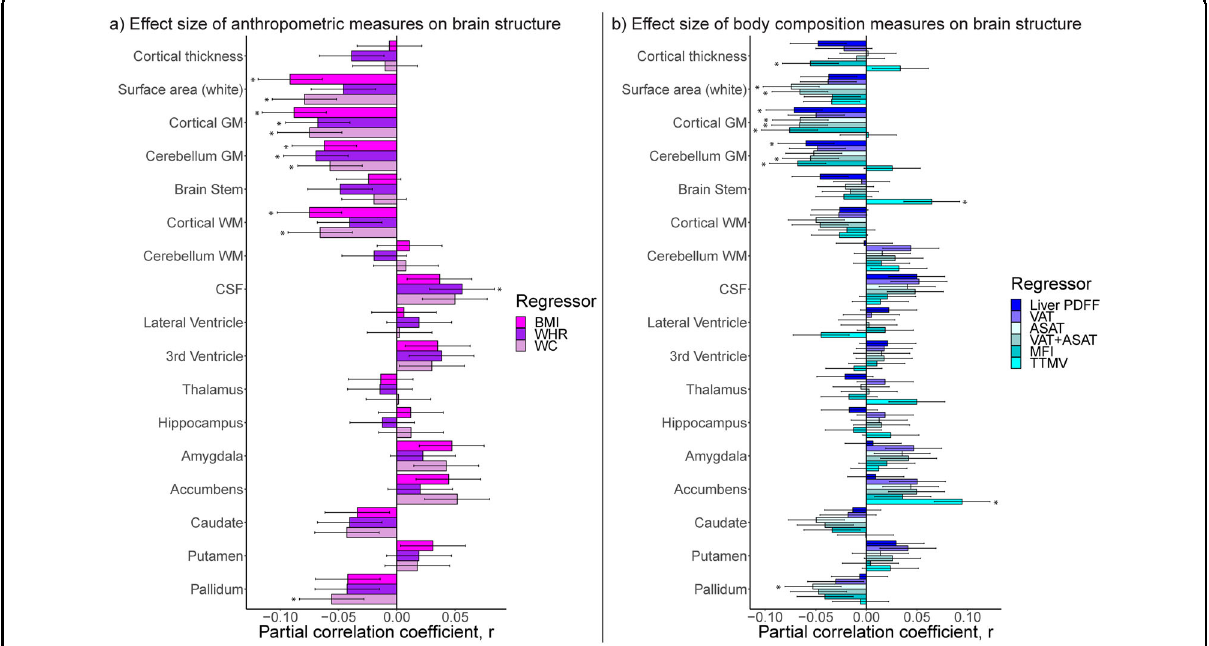
Fig. 4 Linear body – brain association patterns for anthropometric and body composition measures ( n = 4973). Results from model 2c that investigates body – brain connections through the inclusion of linear and quadratic terms of anthropometric and body composition measures, here showing the results for the linear term for in ( a ) anthropometric measures, and in ( b ) body composition measures, on brain structure. The regression model was adjusted for age, age 2 , sex, age-by-sex, age 2 -by-sex, intracranial volume (except cortical thickness), lifestyle/metabolic factors, Euler number, and site. Signi fi cant associations indicated by asterisk. Dependent variables CSF, lateral/3rd ventricle were log-transformed. ASAT abdominal subcutaneous adipose tissue, BMI body mass index, GM gray matter, MFI Muscle Fat In fi ltration, PDFF proton density fat fraction, TTMV total thigh muscle volume, VAT visceral adipose tissue, WC waist circumference, WHR waist-to-hip ratio, WM white